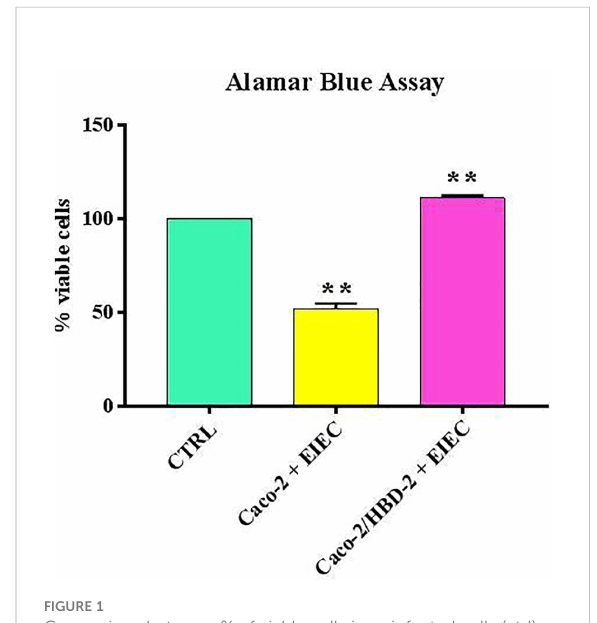
FIGURE 1 Comparison between % of viable cells in uninfected cells (ctrl), transfected and untransfected cells after 6 hours of infection with EIEC. Data are representative of three different experiments ± SD Signi fi cant differences are indicated by